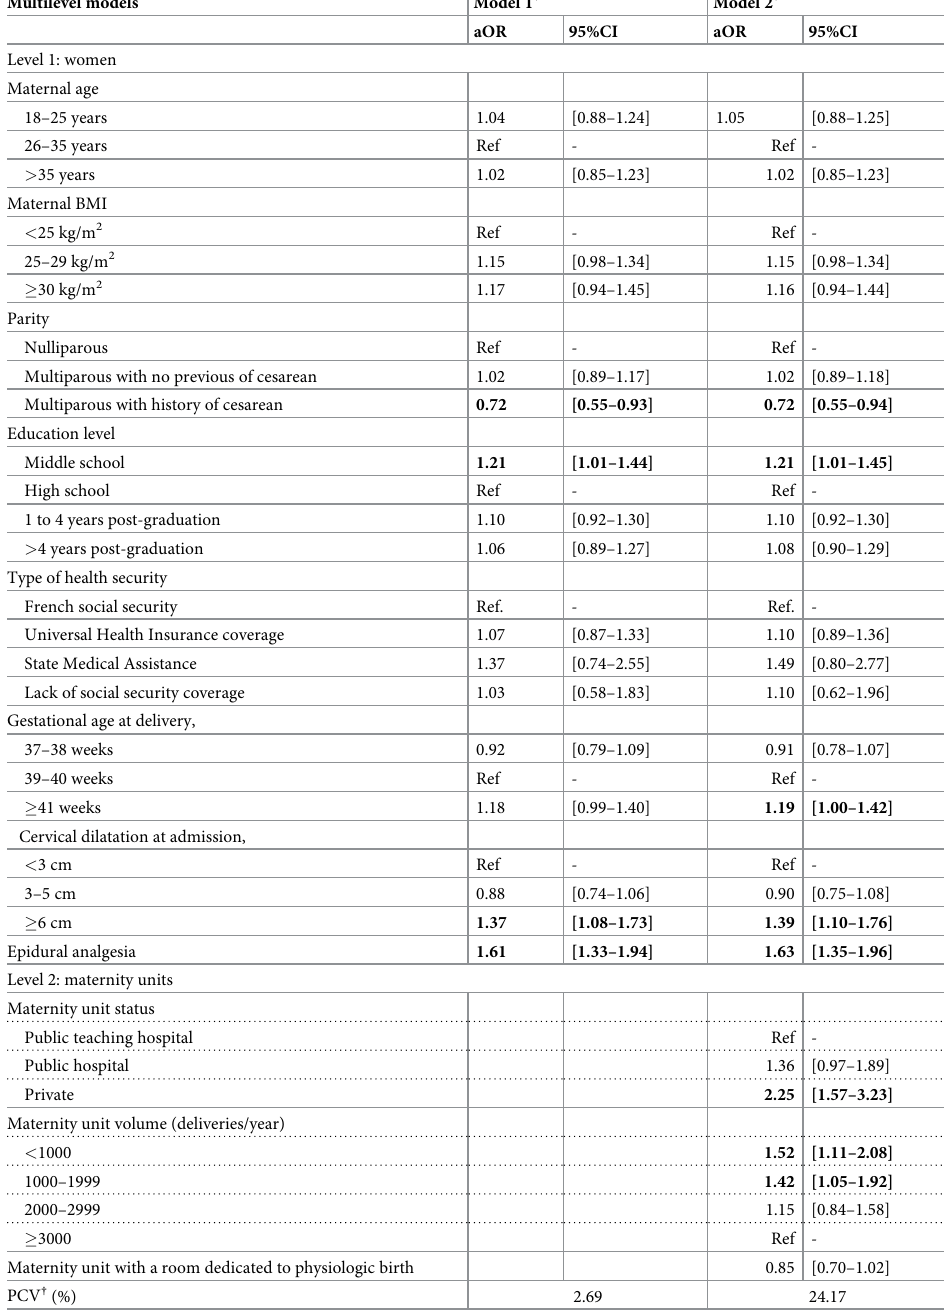
Table 2. Association of women’s socio-demographic characteristics, labor characteristics, maternity unit status and volume and misuse of augmentation of labor, multilevel model, reference: No misuse of augmentation of